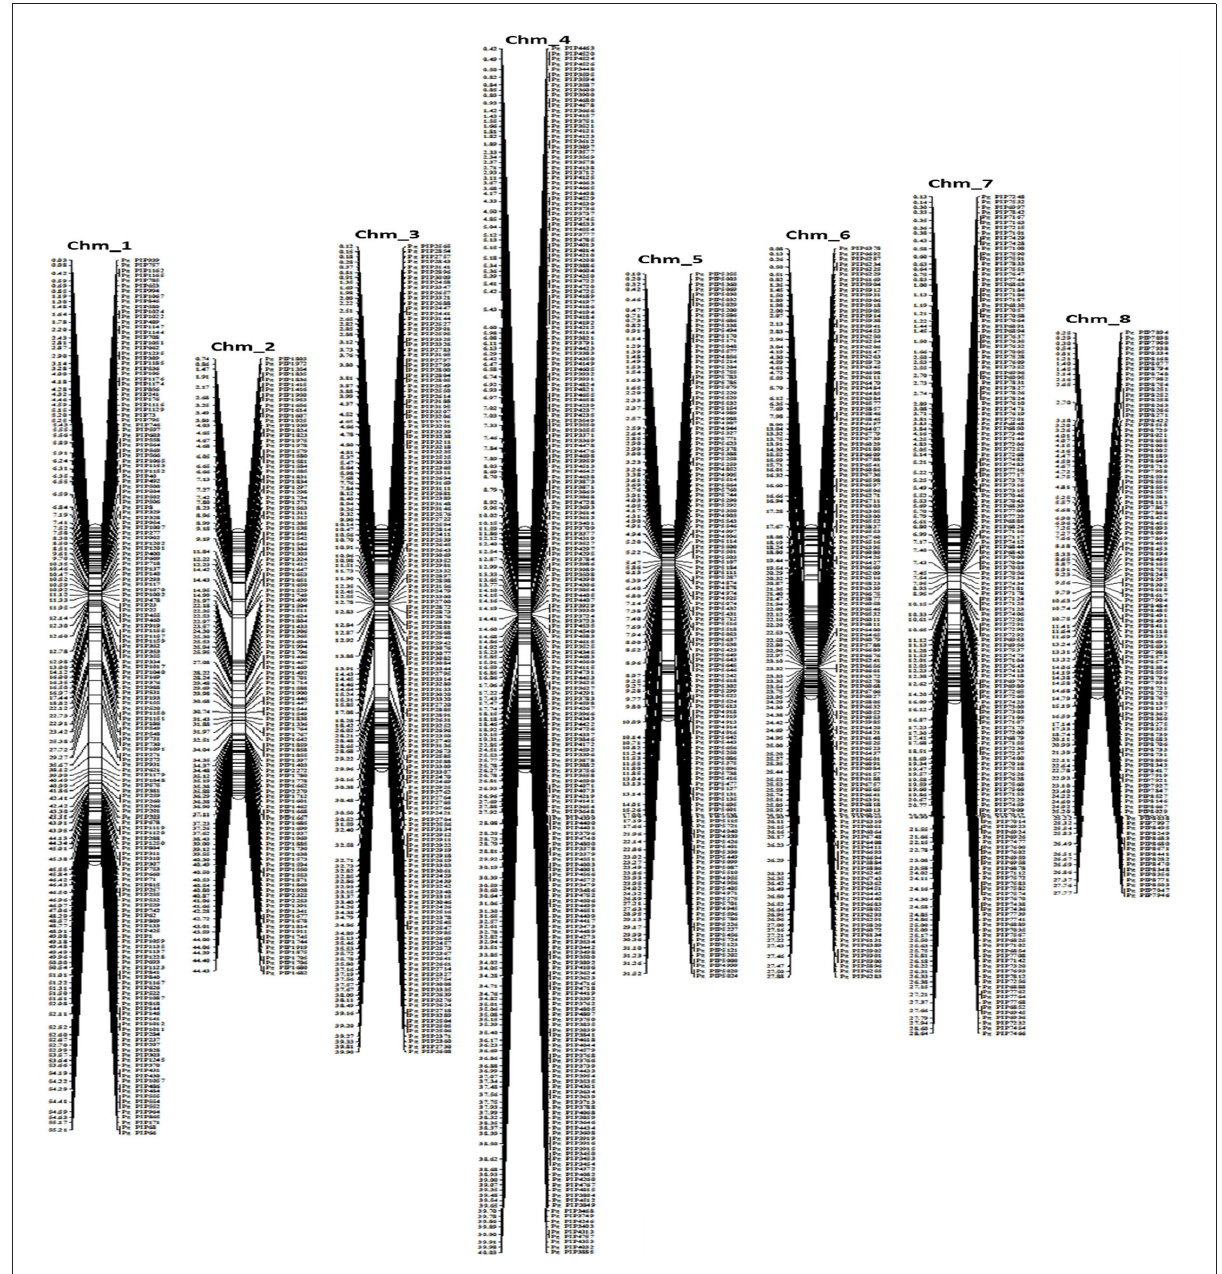
FIGURE3 Physical linkage map based on 1233 PIP markers of the Tunisia genome.